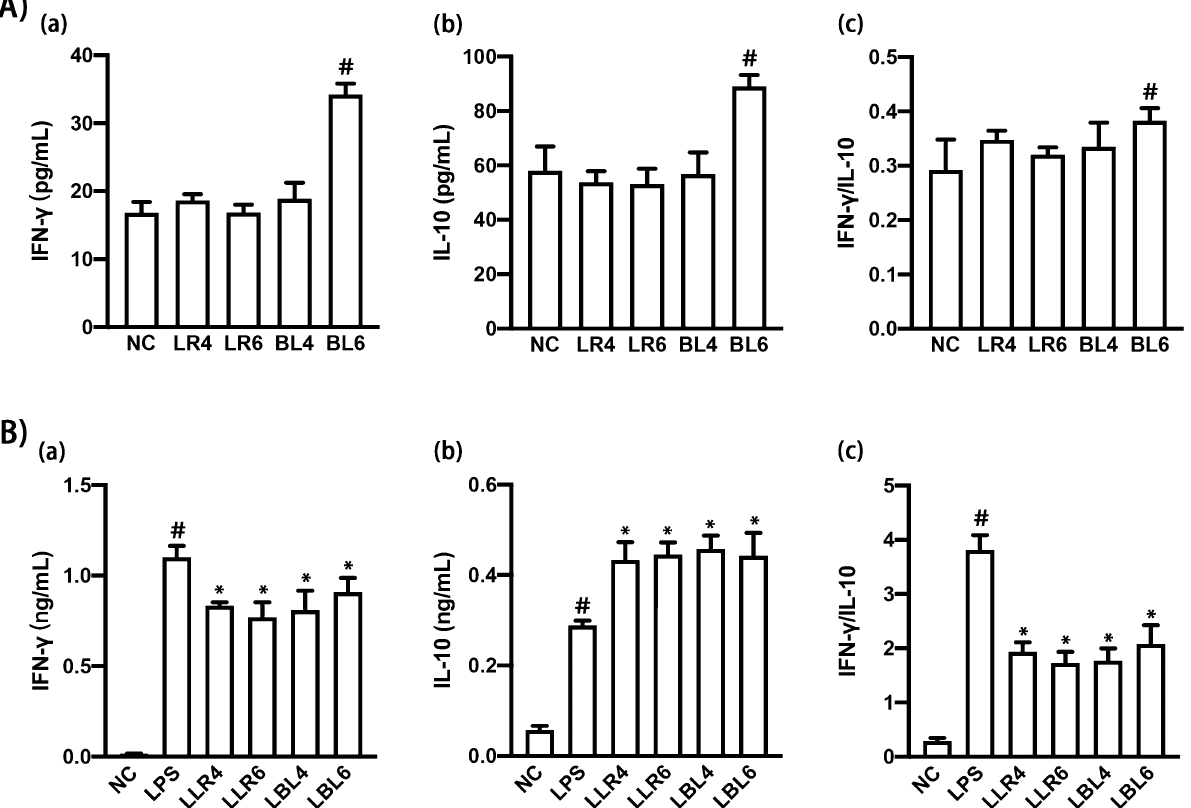
Figure 1. Effect of NK210 and NK219 on the expression of interferon (IFN)-γ and IL-10 in macrophages stimulated with or without LPS. ( A ) Effect on IFN-γ (a) and IL-10 expression (b) and IFN-γ to IL-10 expression ratio (c) in resident macrophage cells. ( B ) Effect on IFN-γ (a) and IL-10 expression (b) and IFN-γ to IL-10 expression ratio (c) in LPS-stimulated macrophage cells. Macrophage cells (1 × 10 6 /mL) isolated from peritoneal cavity were incubated with Lactobacillus rhamnosus NK210 (LR4, 1 × 10 4 CFU/mL NK210; LR6, 1 × 10 5 CFU/ mL) or Bifidobacterium longum NK219 (BL4, 1 × 10 4 CFU/mL NK210; BL6, 1 × 10 5 CFU/mL) in the absence or presence of LPS. Normal control group (CON) was treated with saline instead of LPS. Data values were described as mean ± SD (n = 4). Data values indicate mean ± SD. # p < 0.05 versus NC group. * p < 0.05 versus LP